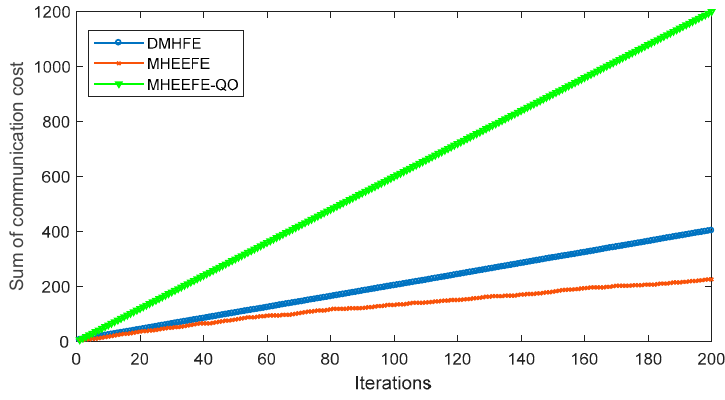
Figure 10. The sum of communication cost.